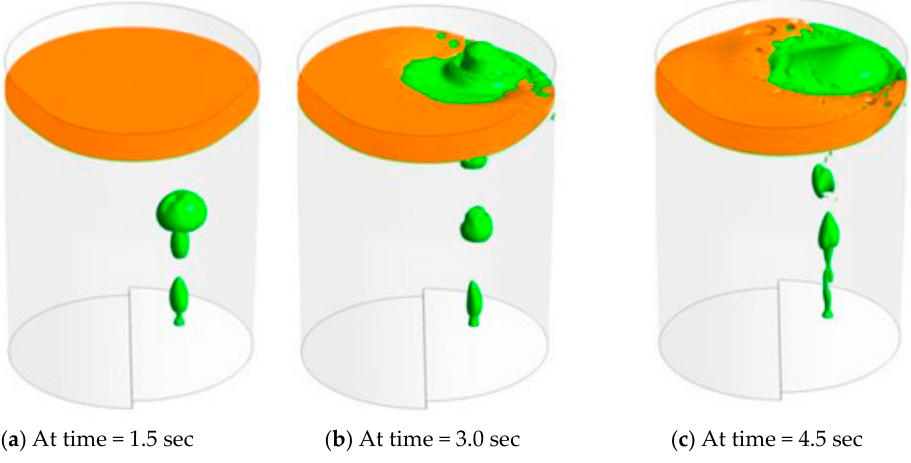
Figure 3. The argon gas floating and open-eye formation process: Q = 500 NL/min.